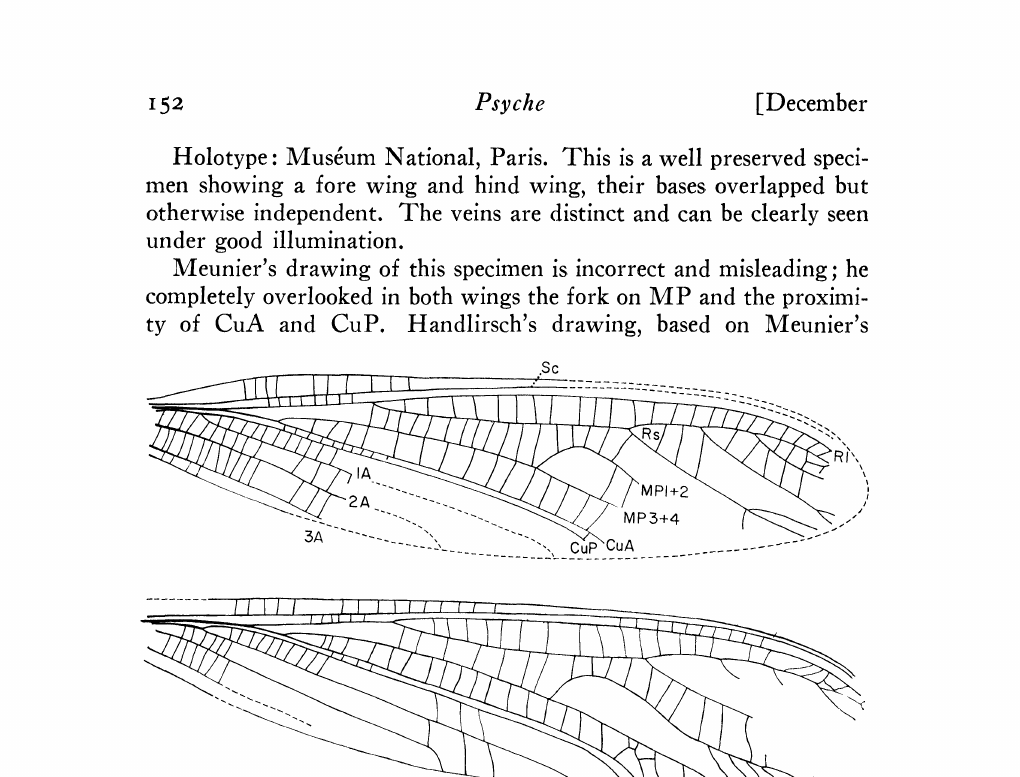
Figure 2. Homal@tila similis (Meunier). Fore and hind wing, based on holotype in Mus6um National, Paris. Lettering as in figure 1. published photograph, was equally inaccurate, showing the hind wing with a broad anal area. However, even though the wings are slightly overlapped basally, the margins of the wings are